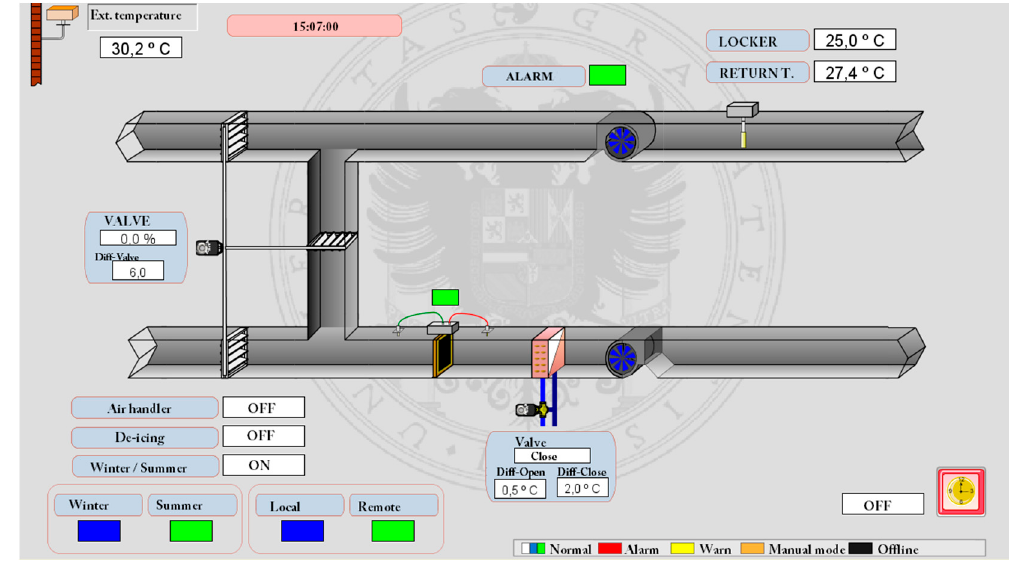
Figure 7. Sample of control ventilation system.